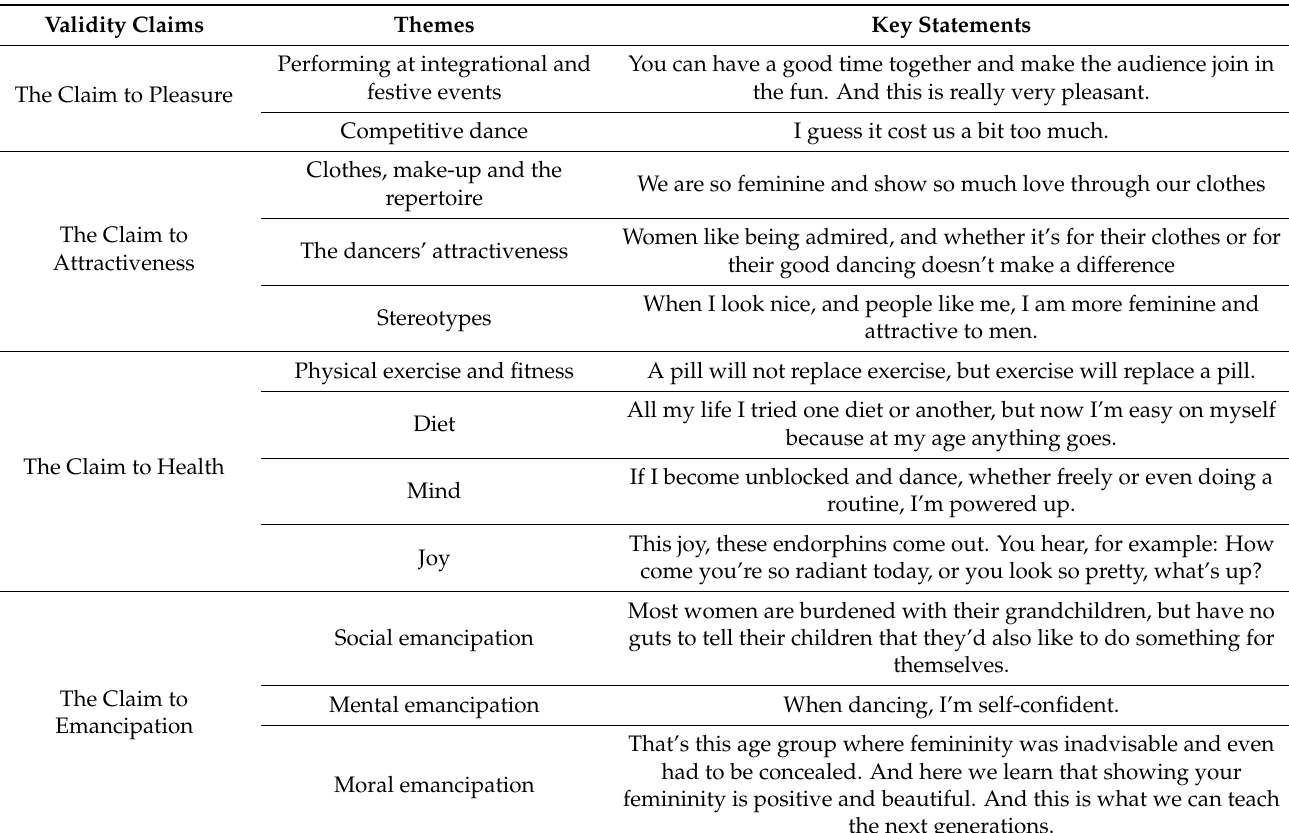
Table 1. Validity claims with their corresponding themes and key